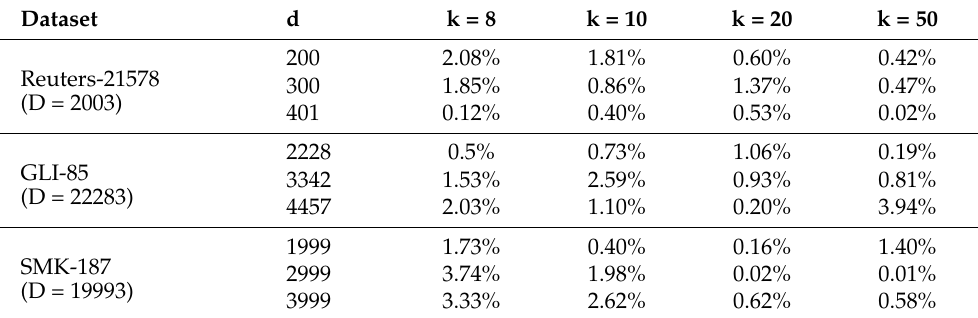
Table 1. Comparison with (cid:101) .